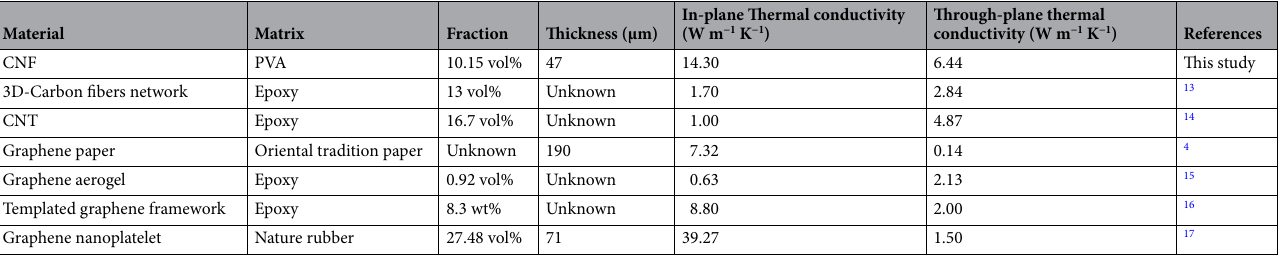
Table 2. Comparison of thermal conductivity of our CNF sheet with other carbon-based thermally conductive